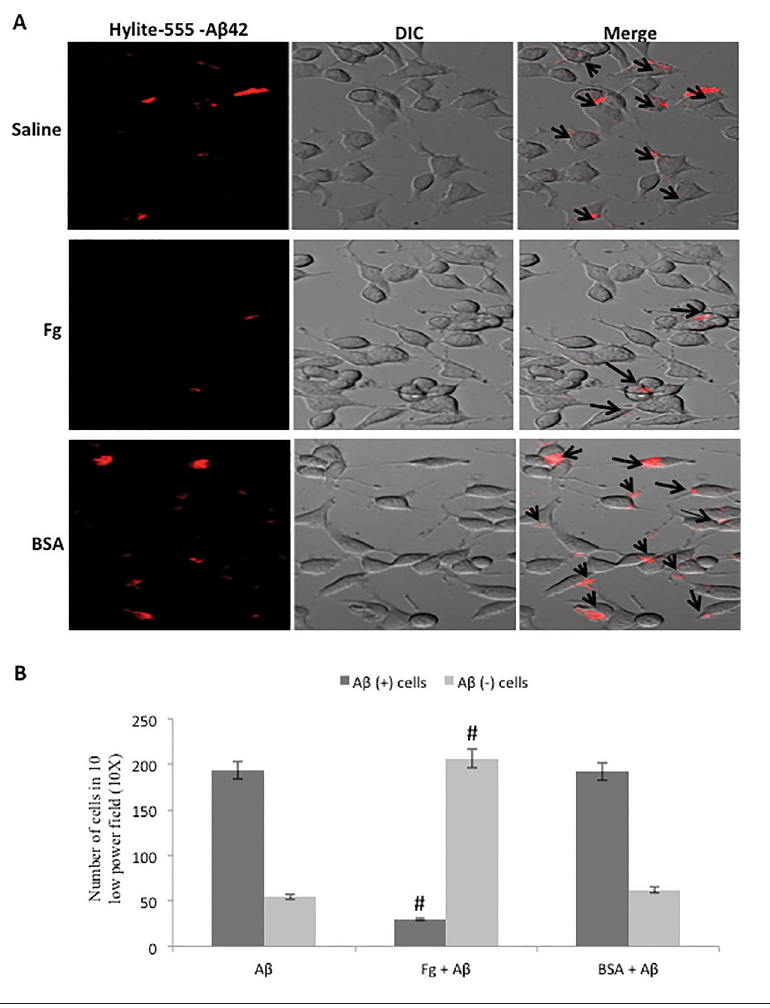
in neuronal cells. (A) SH-SY5Y cells labeled with Figure 5. Intracellular localization of A β 42 Hylite-555-A β pretreated with saline (upper panel), fibrinogen (middle panel) or BSA 42 (lower panel). Arrows indicate localization of A β (red) inside cells. (B) The bars repre- 42 sent the number of SH-SY5Y cells positive and negative for A β . Data are representative 42 of about 250 cells counted in 10 low-power (10×) fields. # p < 0.05 with respect to A β - 42 treated cells in the absence of